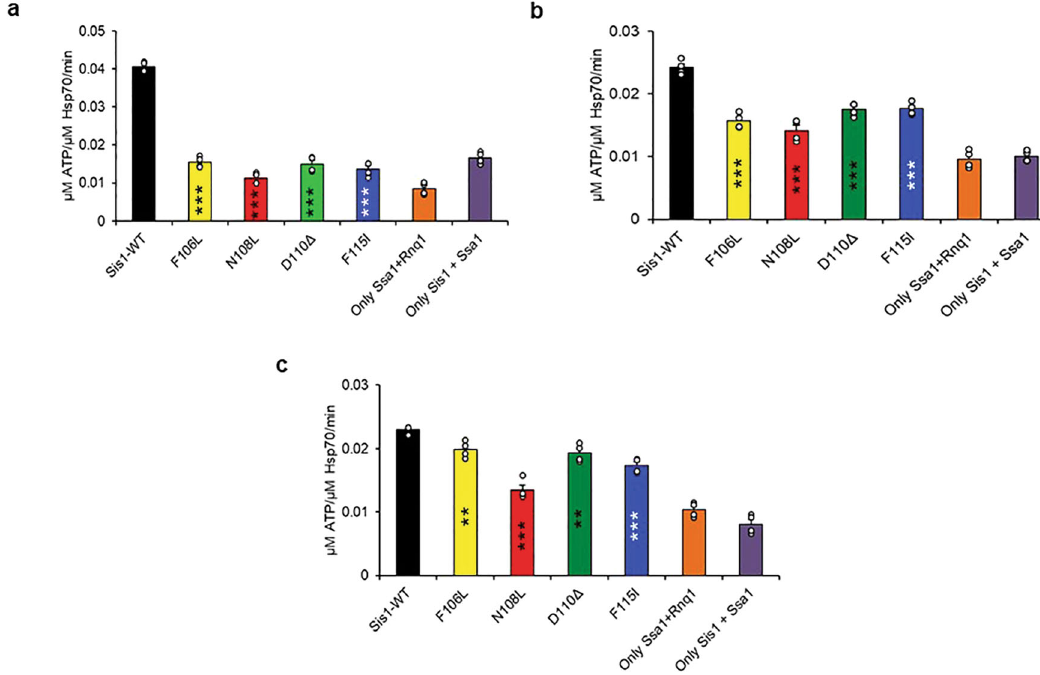
Fig. 3 | Stimulation ofATPaseactivity ofSsa1 byLGMDD1 G/Fdomain mutants is client-conformation speci fi c. Stimulation of Ssa1 ATPase activity in the pre- sence of Rnq1 seeds formed at a 18°C, b 25°C, and c 37°C. Ssa1 (1 µ M) in complex with ATP (1mM) in the presence of Sis1-WT (black) or Sis1-mutants (Sis1-F106L (yellow), Sis1-N108L (red), Sis1-D110 Δ (green), or Sis1-F115I (blue)) (0.05 µ M). The fraction of ATP converted to ADP was determined. For a – c , a total of 10% seeds were used in a reaction. In all cases, only Ssa1 with Rnq1 (orange), Sis1 with Ssa1